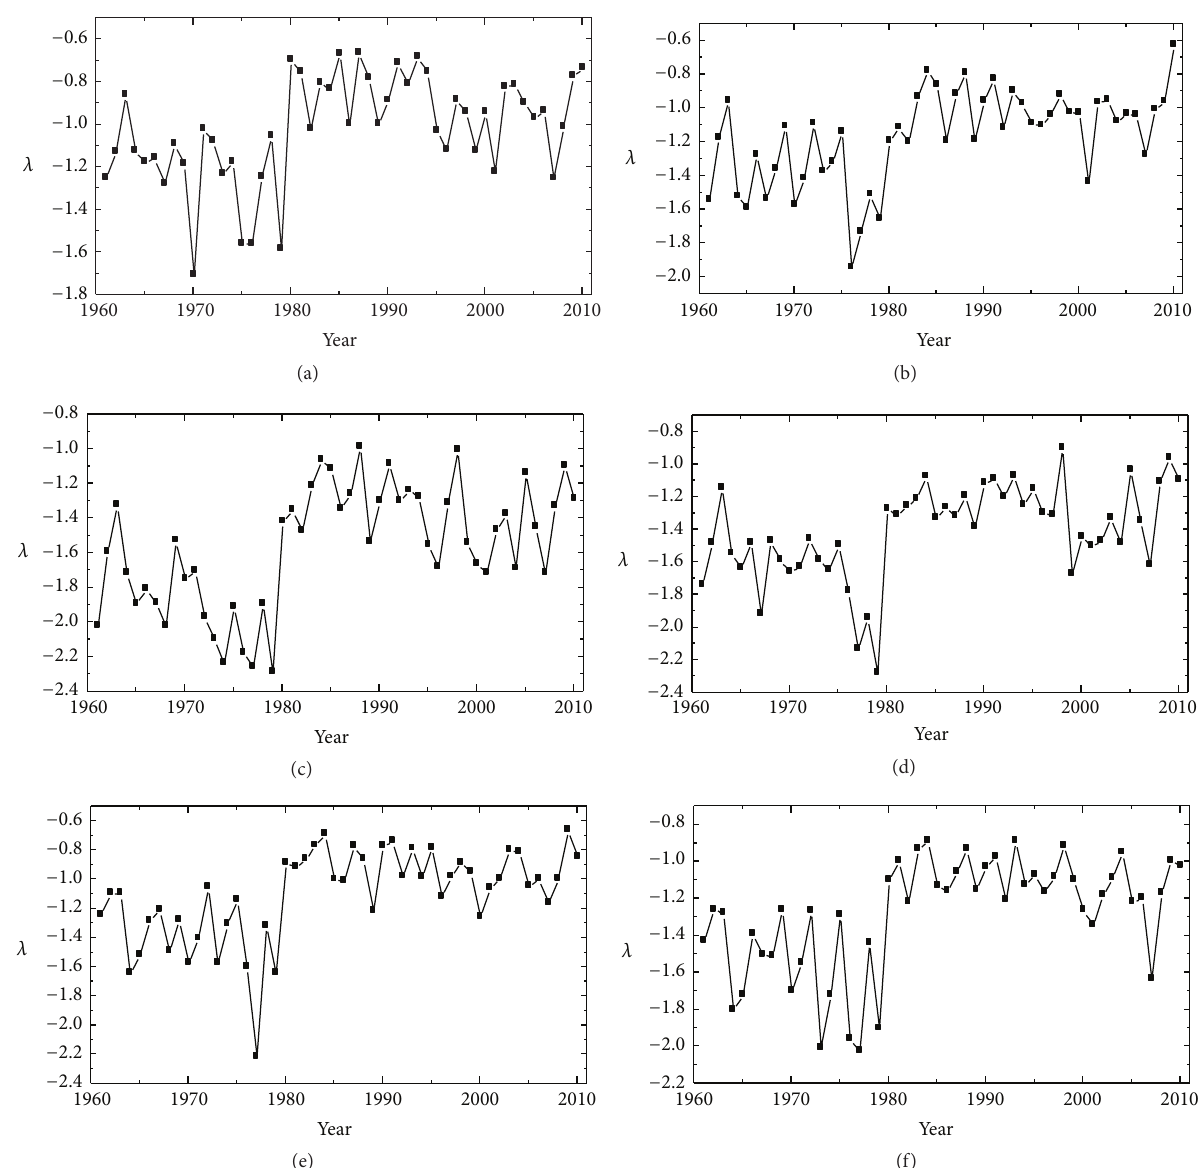
Figure 2: The STP results for daily precipitation records (from 1961 to 2010) in six meteorological observational stations in China, and the samplesizeofslidingwindowis1year:(a)TongheinHeilongjiangProvince;(b)HailuninHeilongjiangProvince;(c)QiqihaerinHeilongjiang Province; (d) Zhalantun in Inner Mongolia; (e) Sunwu in Heilongjiang Province; (f) Nenjiang in Heilongjiang Province